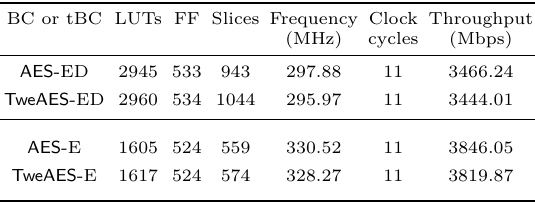
Table 5: Implementation results for AES and TweAES on Virtex 7 FPGA. Here ED stands